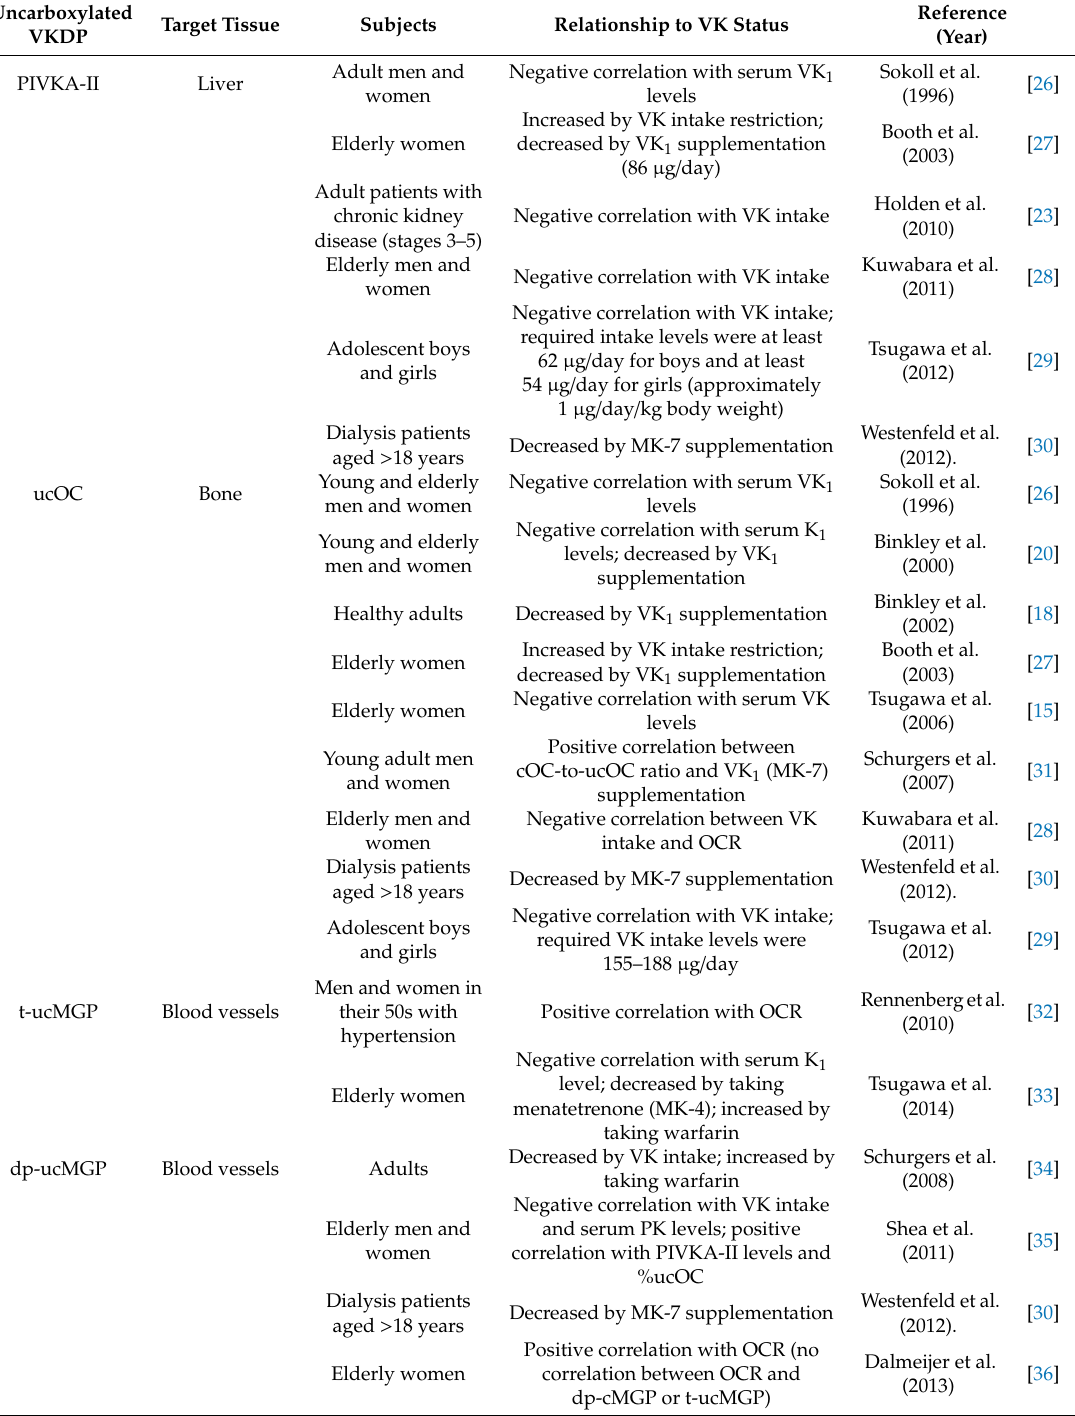
Table 2. Relationship between uncarboxylated vitamin K dependent proteins (VKDPs) and vitamin K